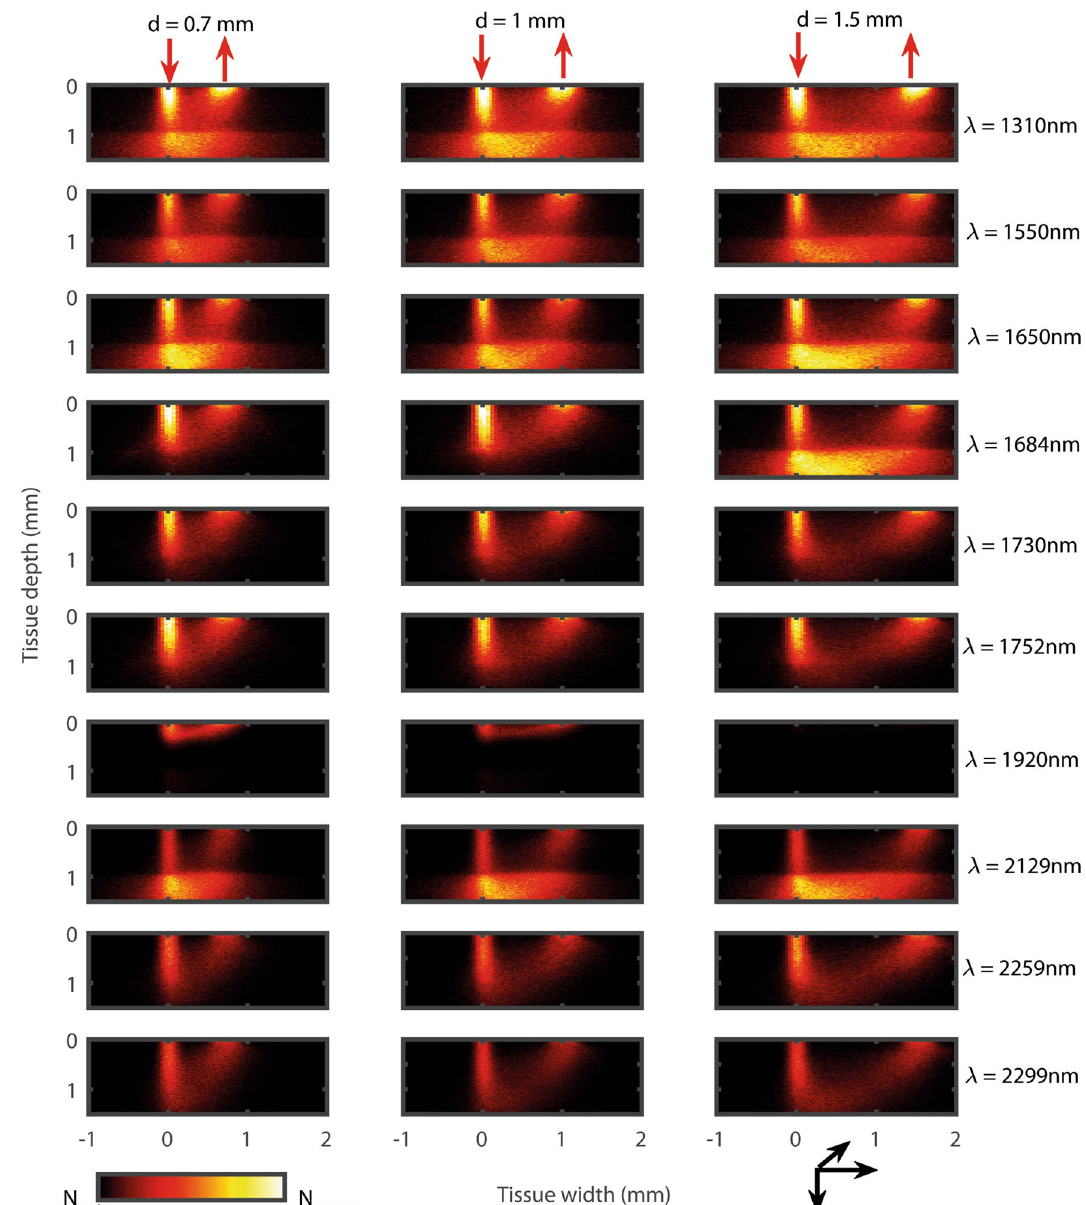
1730 nm, 1752 nm, 1920 nm, 2129 nm, 2259 nm and 2299 nm) are presented along the columns and the rows, respectively. The colorbar represents the number distribution of the interaction events (N) between its minimum and maximum